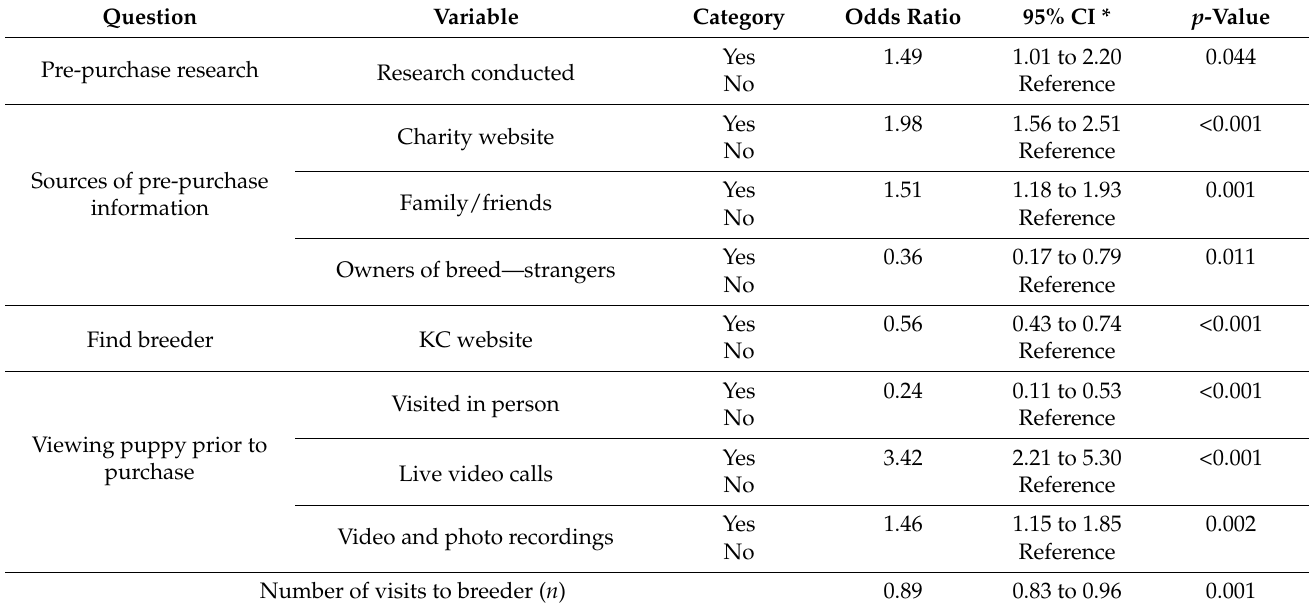
Table 10. Final multivariable model for pre-purchase behaviours associated with purchasing a ‘Pandemic Puppy’ in the UK during 2020. * Confidence interval.